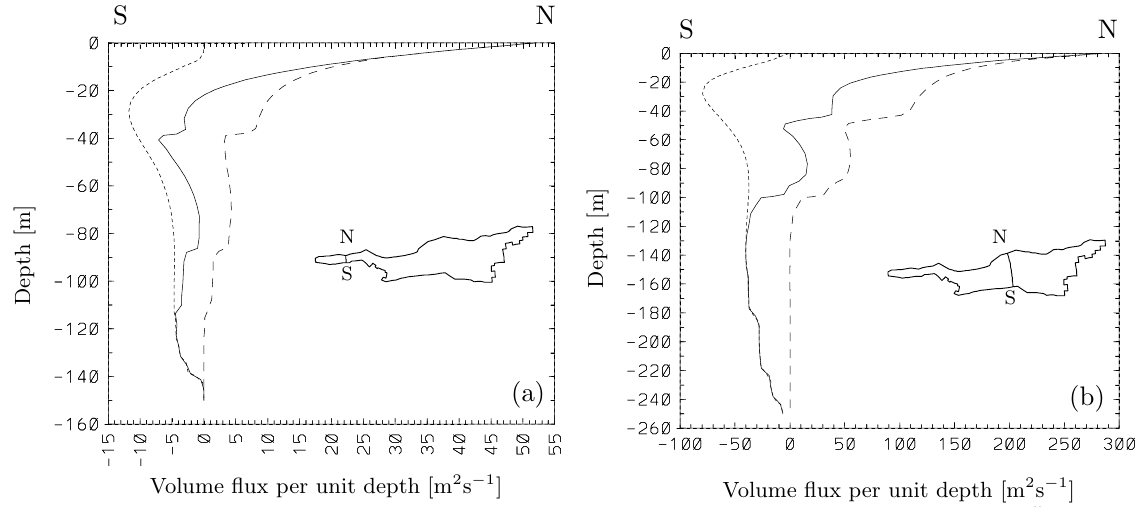
FIG. 18: Horizontally integrated volume flux per unit depth through the cross-sections in the ¨Uberlinger See (a) and in the Obersee (b) as indicated in the insets, computed with the vertical eddy viscosity ν v = 0 . 02m 2 s − 1 . Broken curves indicate the transport part with the wind, dotted curves against the wind direction. The solid lines show the net volume